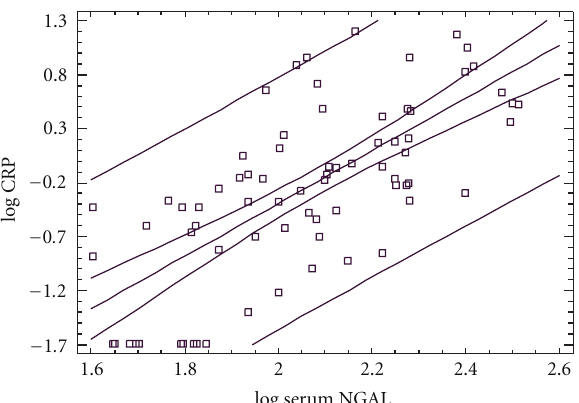
Figure 3: Regression analysis between serum-NGAL and hs-CRP.